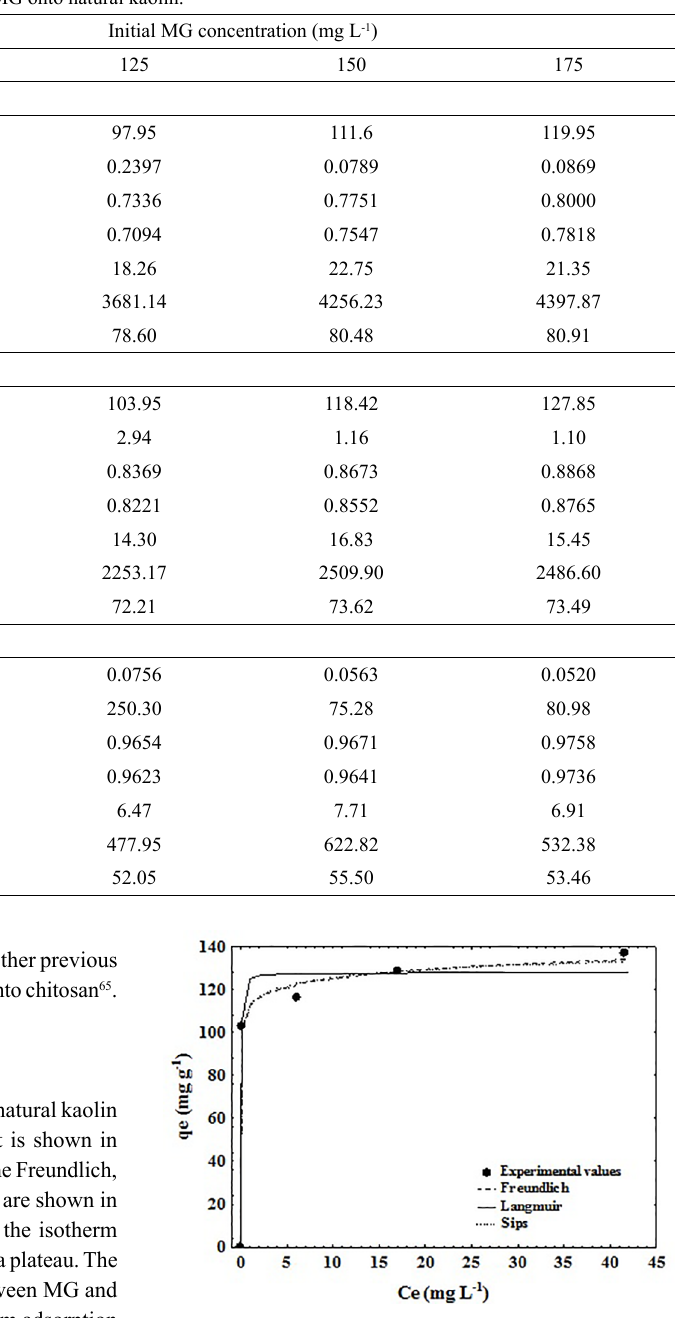
Figure 9. Isotherm curve for the adsorption of MG onto natural kaolin. Experimental conditions: pH = 6.3; T = 25 ºC. that the MG adsorption onto kaolin was a favorable